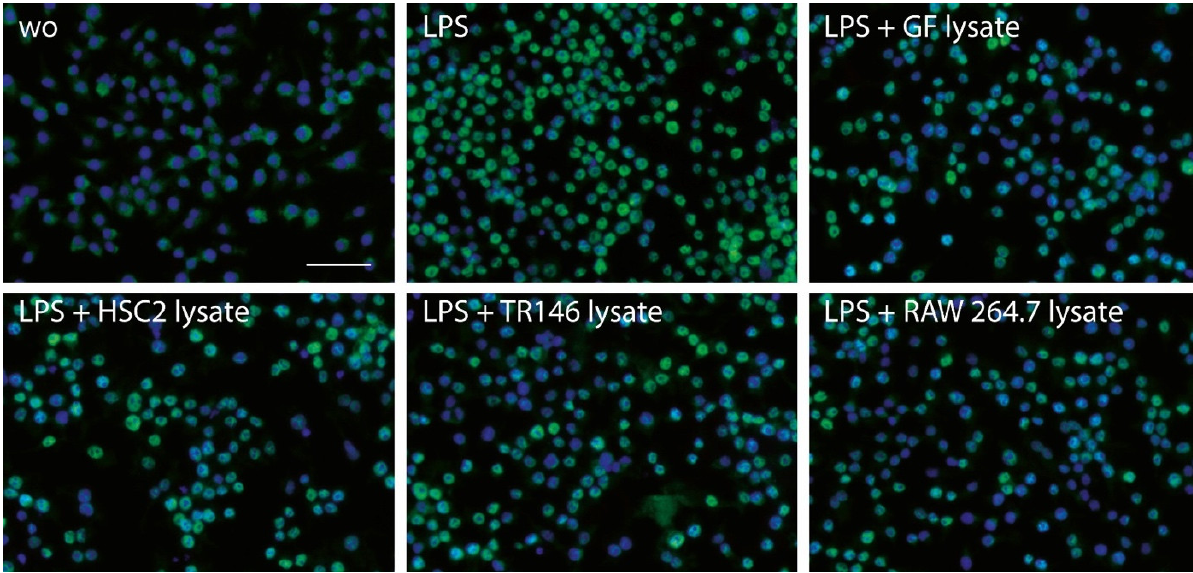
Figure 5. Necrotic cell lysates reduce LPS-induced p65 nuclear translocation in RAW264.7 cells. We used RAW264.7 macrophages exposed to LPS in the presence and absence of necrotic cell lysates from gingival fibroblasts (GF), HSC2, TR146 (TR), and RAW264.7 (RAW) prepared by sonication aiming to induce the nuclear translocation of p65. Immunostaining revealed the green fluorescence signals obtained with the p65 antibody. Note that almost all cells are positive upon LPS treatment, while the cell lysates shift this pattern toward visible blue nuclear staining with DAPI. The scale bar indicates 50 µm.